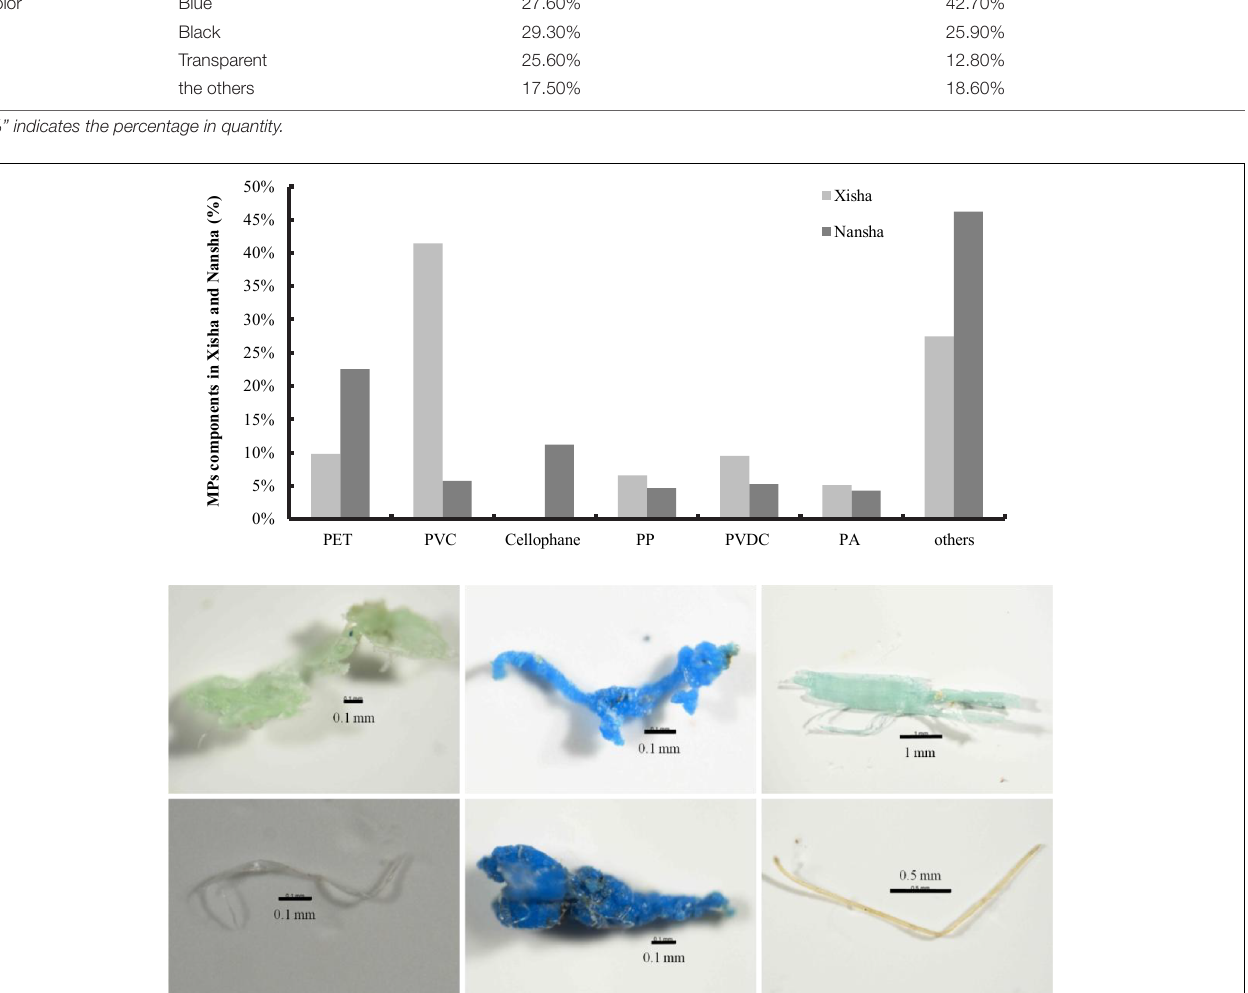
(11.2%), while PVC accounted for 41.5% at Xisha Islands and no cellophane was